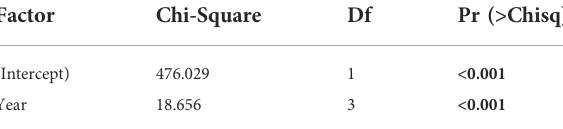
TABLE 4 Effect of “ Year ” on the residue concentrations detected.